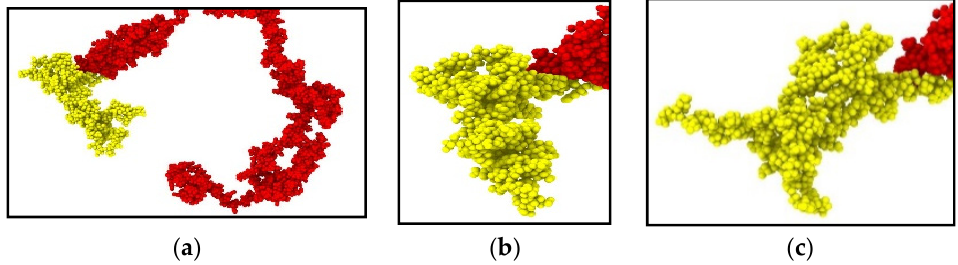
Figure 4. Pre-relaxation stretching for NFL (1 × 10 8 /s). ( a ) Initial structure (0% strain), ( b ) sidearm region at mid-stretch (40% strain), ( c ) sidearm region at end of stretch (80% strain). Color legend: Red: head and rod domain, Yellow: sidearm.